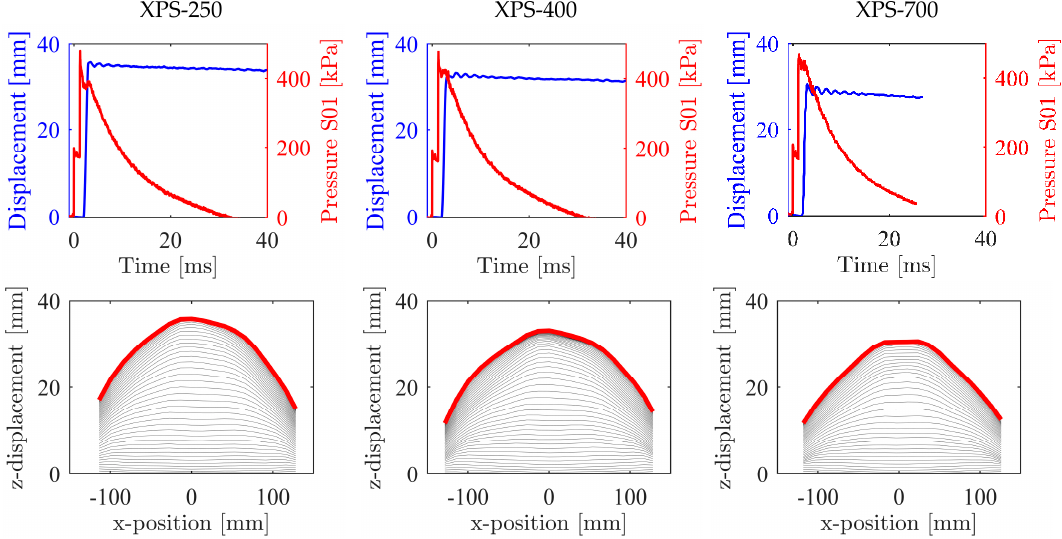
Figure A1. Displacement and pressure versus time (top) and displacement profiles (bottom) for tests on sandwich panels with 12 bar firing pressure.